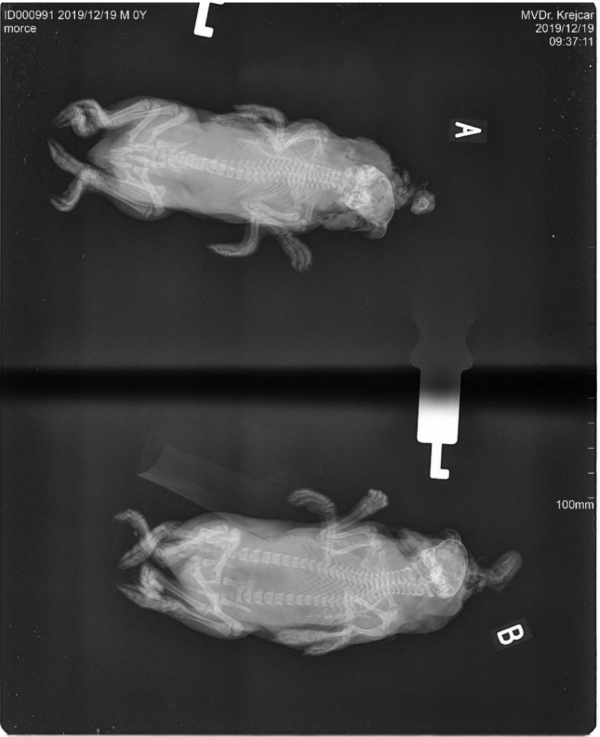
Figure 2. The X-ray images—AP projection (A -anterior, B- posterior).